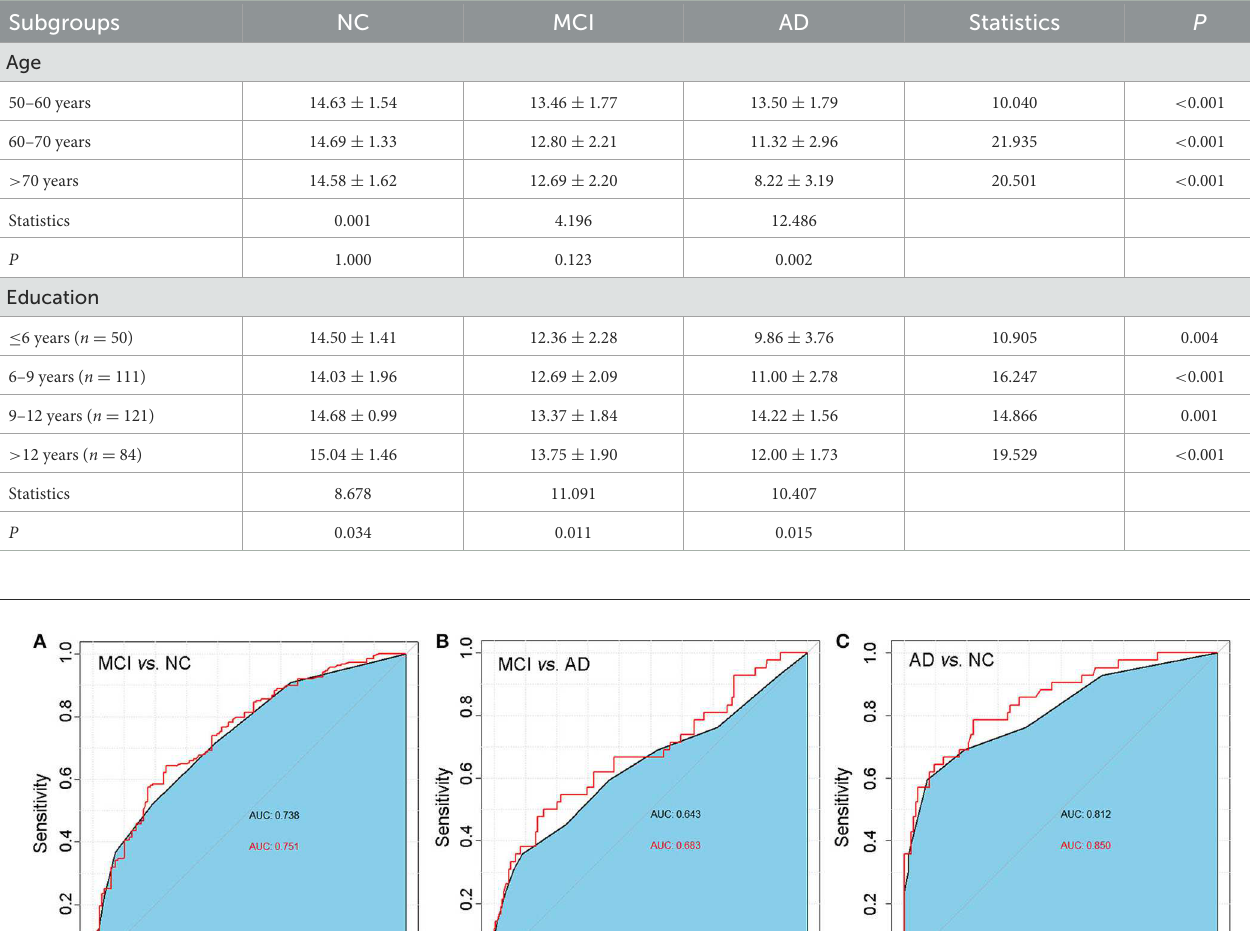
TABLE 5 Subgroup comparison of the CSIT score stratified by age and educational levels. Subgroups